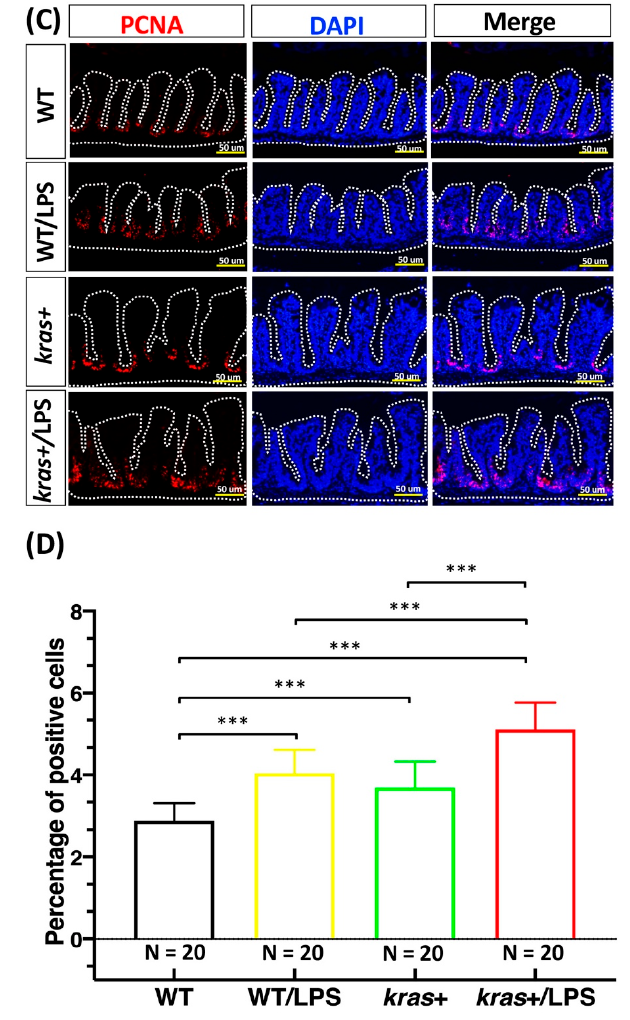
Figure 4. Expression of kras V 12 with LPS treatment enhanced the increase in cell apoptosis and cell proliferation in the intestinal epithelium. ( A , C ) Immunofluorescence staining (red) was carried out in intestinal paraffin sections of WT (n = 20), WT/LPS (n = 20), kras+ (n = 20), and kras+/LPS (n = 20) zebrafish. ( B , D ) Immunofluorescence staining of caspase-3 showing (1) apoptosis and (2) PCNA as a marker for cell proliferation as well as (3) quantification of the number and percentage of positive cells. Differences among the variables were assessed using Student’s t-tests. Statistical significance: * p < 0.05, *** p < 0.001. Scale bar: 50 μ m.